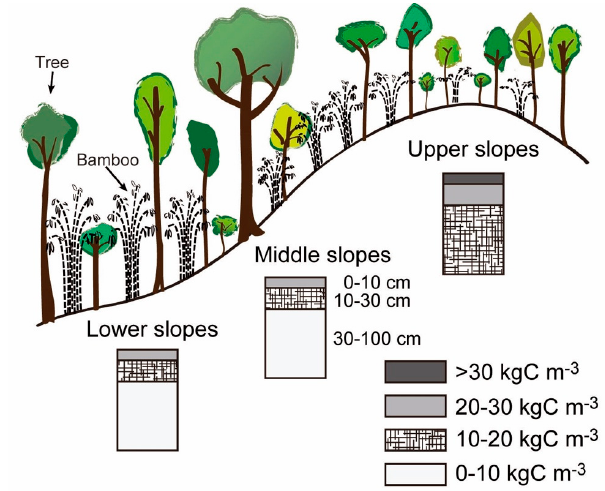
Figure 3. Schematic illustration of the slope positions and soil carbon densities in the mixed deciduous forest at the Mae Klong Watershed Research Station.